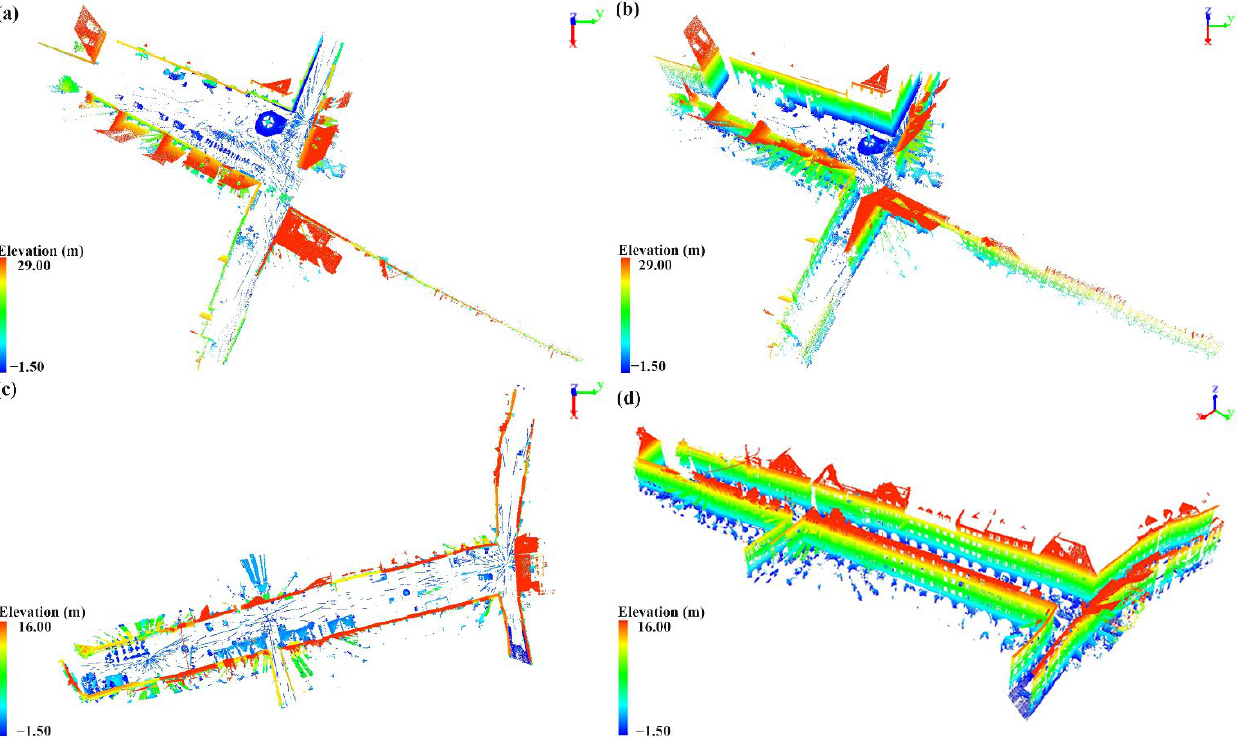
Figure 13. Raw experimental data for the Semantic3D.Net Benchmark dataset: ( a , b ) the processed point cloud data of the “domfountain” scene in 2D view and 3D view, respectively; and ( c , d ) the processed point cloud data of the “marketsquarefeldkirch” scene in 2D view and 3D view, respec- tively.